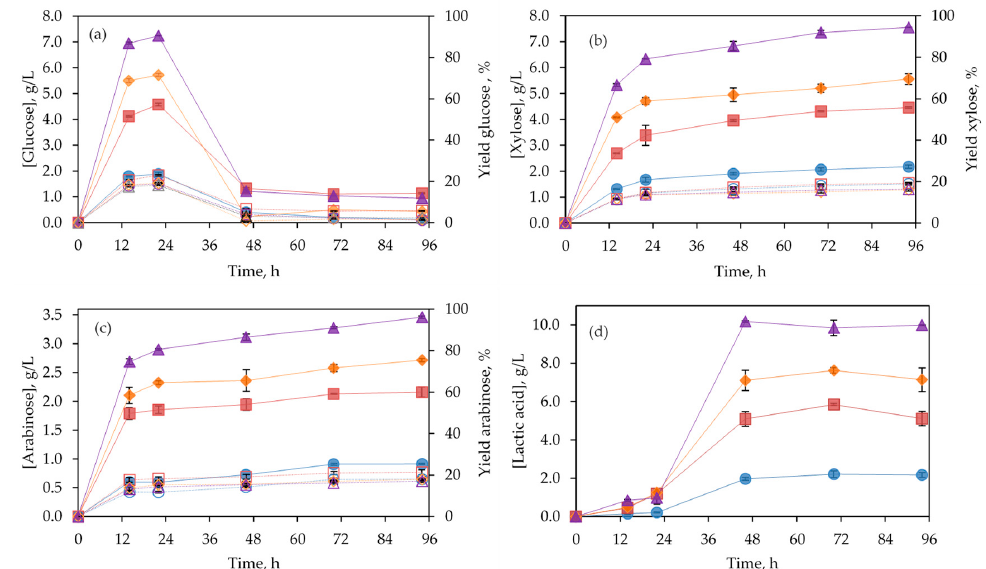
Figure 3. Time course of enzymatic hydrolysis of raw BSG at different solids’ loading • ○ 5% ( w/v ), (cid:4)(cid:3) 10% ( v/w ), (cid:7) 15% ( w/v ), (cid:78) (cid:52) 20% ( w/v ); ( a ) glucose; ( b ) xylose; ( c ) arabinose; ( d ) lactic acid. Compounds concentrations (g/L) (filled symbol) and yield (open symbol), expressed as g compound per 100 g of compound in BSG. Experiments were conducted in duplicate. Analytical measurements were conducted in